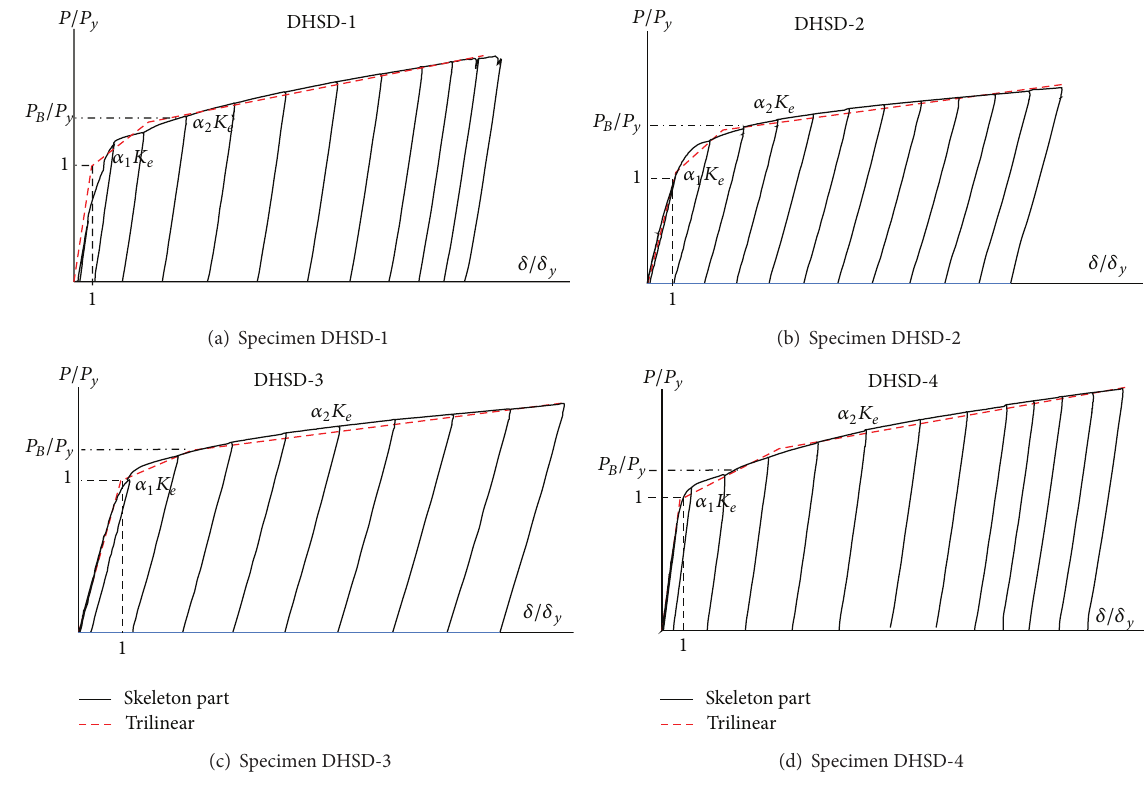
Figure 17: Comparison of skeleton curve and trilinear approximation. Table 6: Mechanical characteristic of trilinear